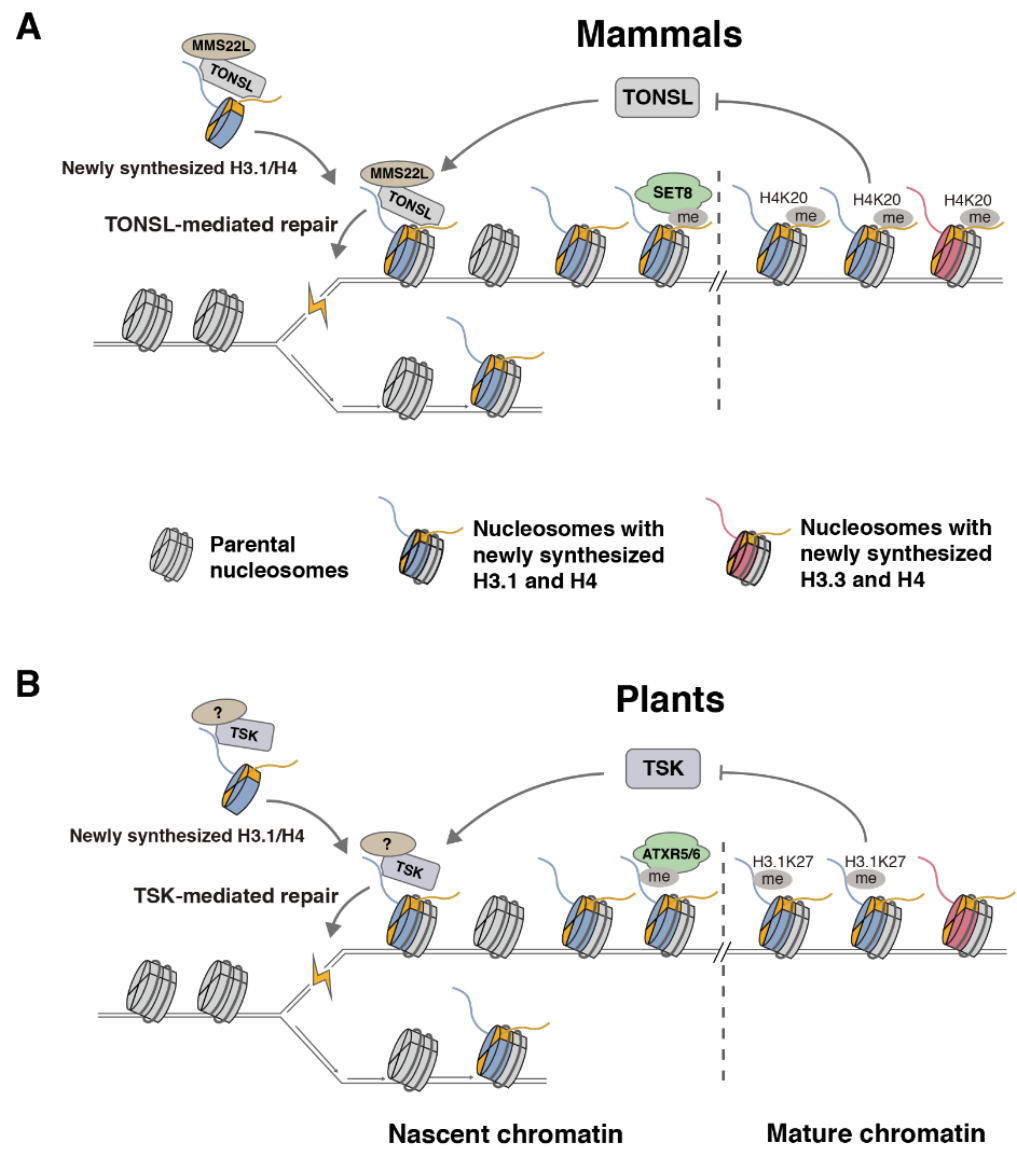
Figure 4. Comparison of the chromatin-based mechanisms regulating TSK/TONSL activity between mammals and plants: ( A ) In mammals, TONSL forms a heterodimer with MMS22L and initially interacts with soluble H3.1/H4 using its TPR and ARD domains. After H3.1/H4 incorporation into nascent chromatin, TONSL–MMS22L recruits HR repair proteins to resolve stalled or broken replication forks. Post-replicative chromatin maturation relies on SET8 to monomethylate H4K20, which prevents the binding of TONSL–MMS22L to mature chromatin; ( B ) plants lack a clear MMS22L homologous protein, and TSK only contains a TPR domain to mediate the interaction with newly synthesized H3.1/H4. In addition, H3.1K27, not H4K20, is monomethylated (via ATXR5/6) to prevent TSK from interacting with mature chromatin. Parental H3/H4 histones are shown in gray; newly synthesized histone proteins are highlighted in blue (H3.1), red (H3.3) or yellow (H4). 5. Differences between Plants and Animals in the TSK/TONSL-H3.1 Pathway